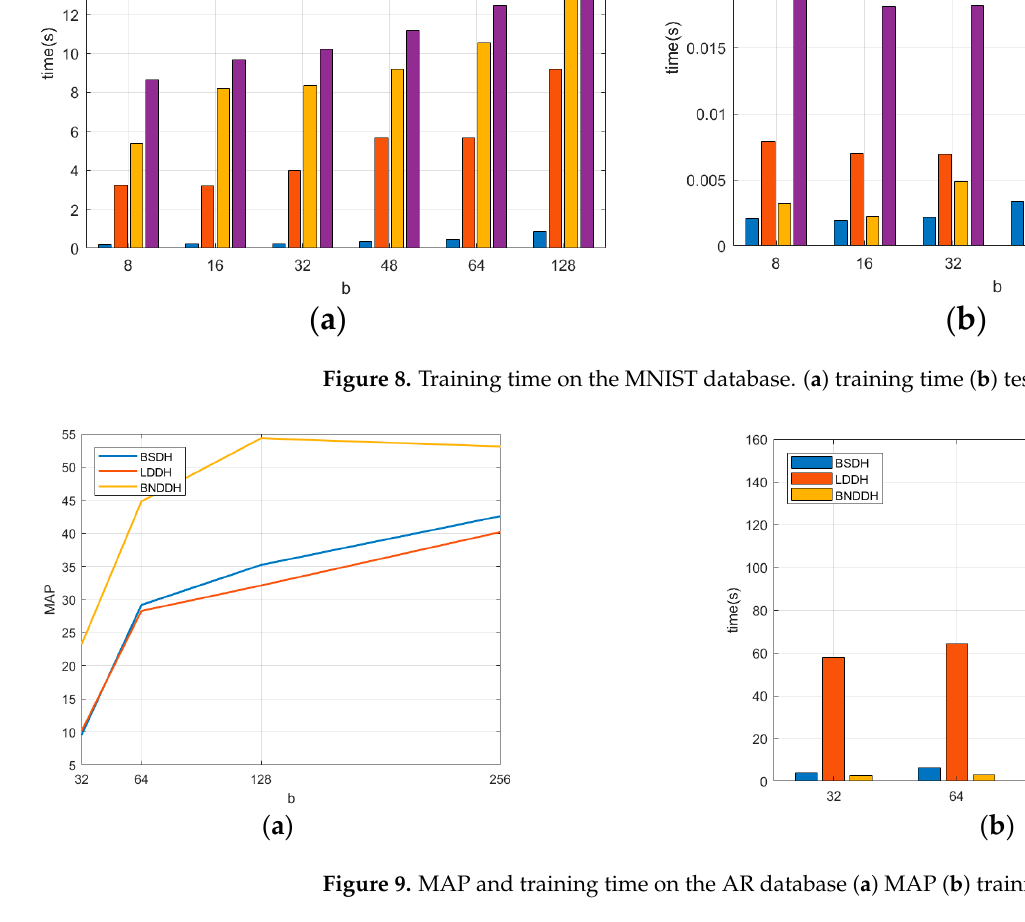
Figure 9. MAP and training time on the AR database ( a ) MAP ( b ) training time.